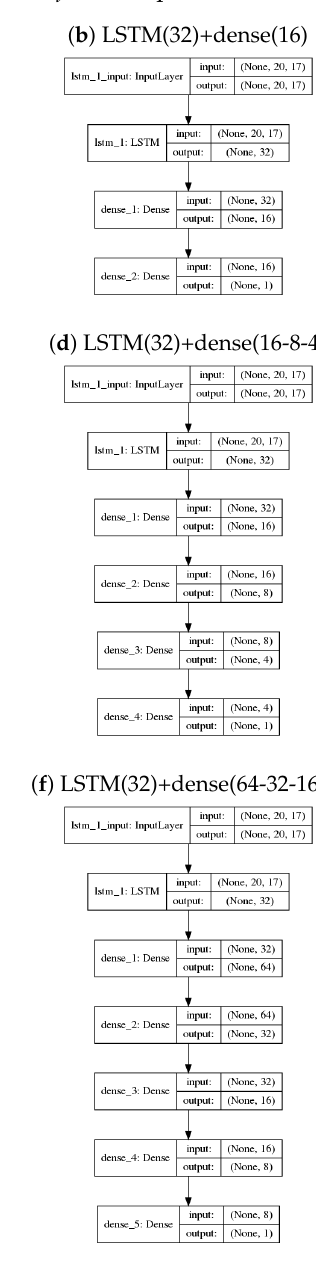
Figure 3. Architectures to be tested. The first dimension in each layer indicate a batch size. The implementation of neural network does not require the input of the batch size; therefore, the first dimension for each layer is a question mark. For example, the first layers of models are input layers and input matrices are of the shape (20, 17). The input and output for input layer are (?, 20, 17). As the first layers are the same and the outputs of the final layers are of dimension one for all models, the architectures are named according to output units of layers excluding the first and final layer. For Figure 3c, after removing the input layer and the final layer, the LSTM layer with 32 output units is followed by a dense layer with 16 output units and a dense layer with 8 output units. Therefore, it is named